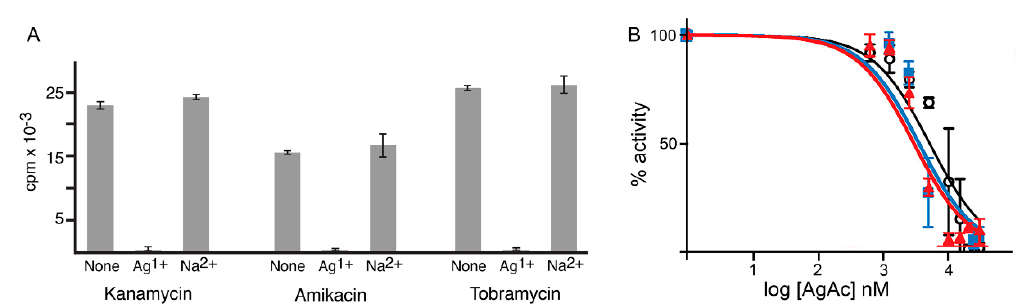
Figure 1. Effect of Ag 1+ on AAC(6 ′ )-Ib activity. ( A ) acetylating activity of AAC(6 ′ )-Ib using kanamycin, tobramycin, or amikacin as substrates in the presence of Ag 1+ . Silver acetate (AgAc) and sodium acetate were added at 100 μ M and the activity was compared to that observed in its absence. ( B ) The percentage of acetylating activity by AAC(6 ′ )-Ib was calculated for reaction mixtures containing different concentrations of silver acetate.